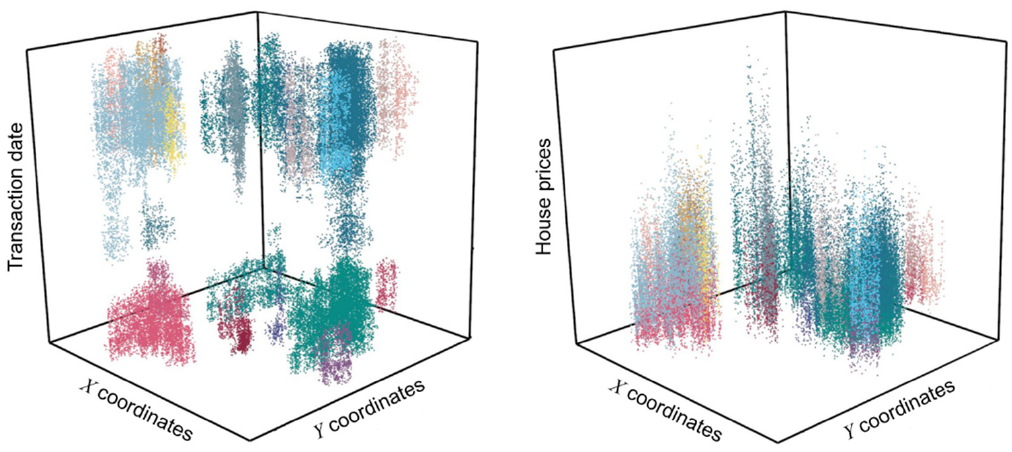
Figure 13. Visualization of clustering results using real transaction price data of detached houses. As shown in Figure 13, the x -axis and y -axis of the graph represent the place’s co- ordinates where the transaction occurred. The z -axis, which is the height, represents the transaction time and price. High z -axis values indicate recent transaction dates, or high prices in the respective graphs. In these results, the clusters corresponding to the latest times and the clusters farther in the past are divided. Similarly, the price results can be divided into high and low clusters. Through this, it can be confirmed that the house price increased as time passed in the corresponding space. In addition, in the case of transaction, there are no clusters in a certain region at the center of the entire period, which can be seen as empty. It has been confirmed that this phenomenon is caused by incidents that cause house prices to appear irregular, such as redevelopment projects, in the area. From these results, we can determine that the MDST-DBSCAN method has derived clusters suitable for the